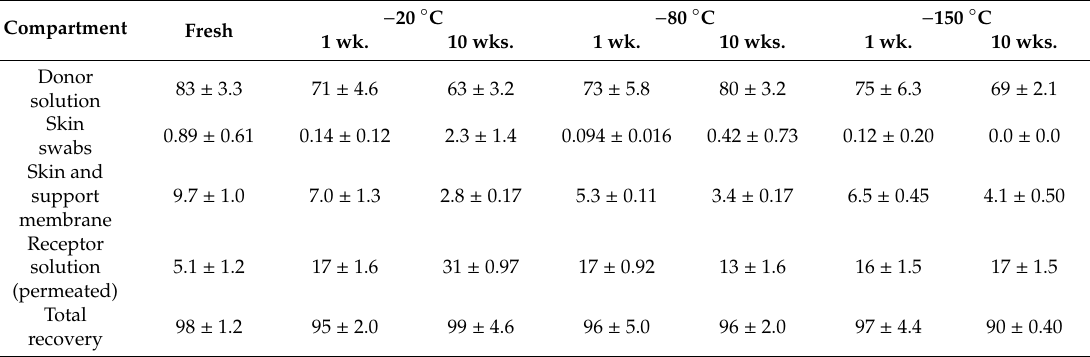
Table 4. Mass balances expressed as percentages of applied resorcinol (mean ± SD).